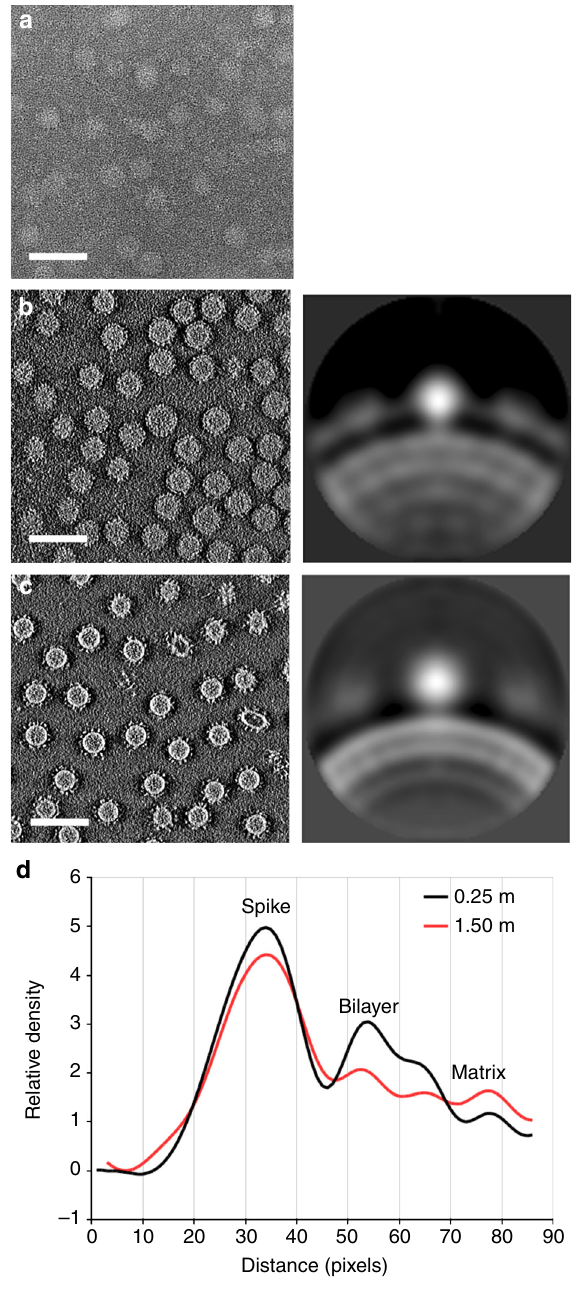
Fig. 3 Effect of NaCl concentration and the Volta-phase plate on the tomographic data. a A slice through a 3D tomogram of HRPV-6 in 1.5M NaCl buffer collected without Volta-phase plate. b A slice through a 3D tomogram of HRPV-6 in 1.5M NaCl buffer collected with Volta-phase plate (left), and the corresponding cross section of cylindrically average spike and density distribution (right). c A slice through a 3D tomogram of HRPV-6 in 0.25M NaCl buffer collected with Volta-phase plate (left), and the corresponding cross section of cylindrically average spike and density distribution (right). d Averaged radial density distributions of HRPV-6 in low (0.25M NaCl) and high salt (1.5M NaCl) are compared. The radial density distribution for the spike is similar at low- and high-salt concentration. The scale bar corresponds to 100 nm. Source data are provided as a Source Data fi